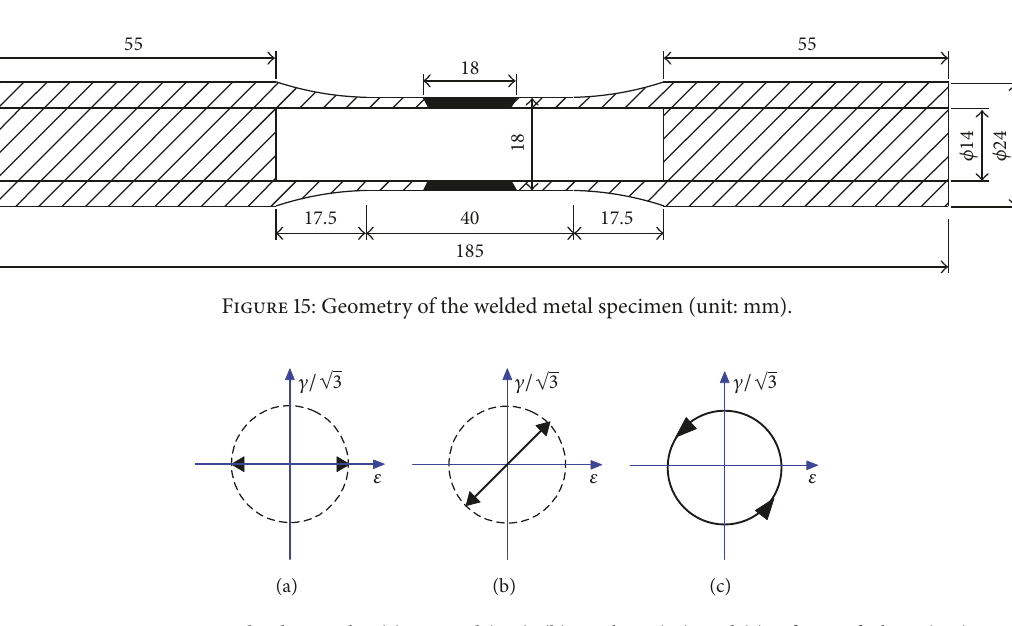
Figure 16: Fatigue test loading paths: (a) uniaxial (UA), (b) in-phase (IP), and (c) 90 ∘ out-of-phase (OP).